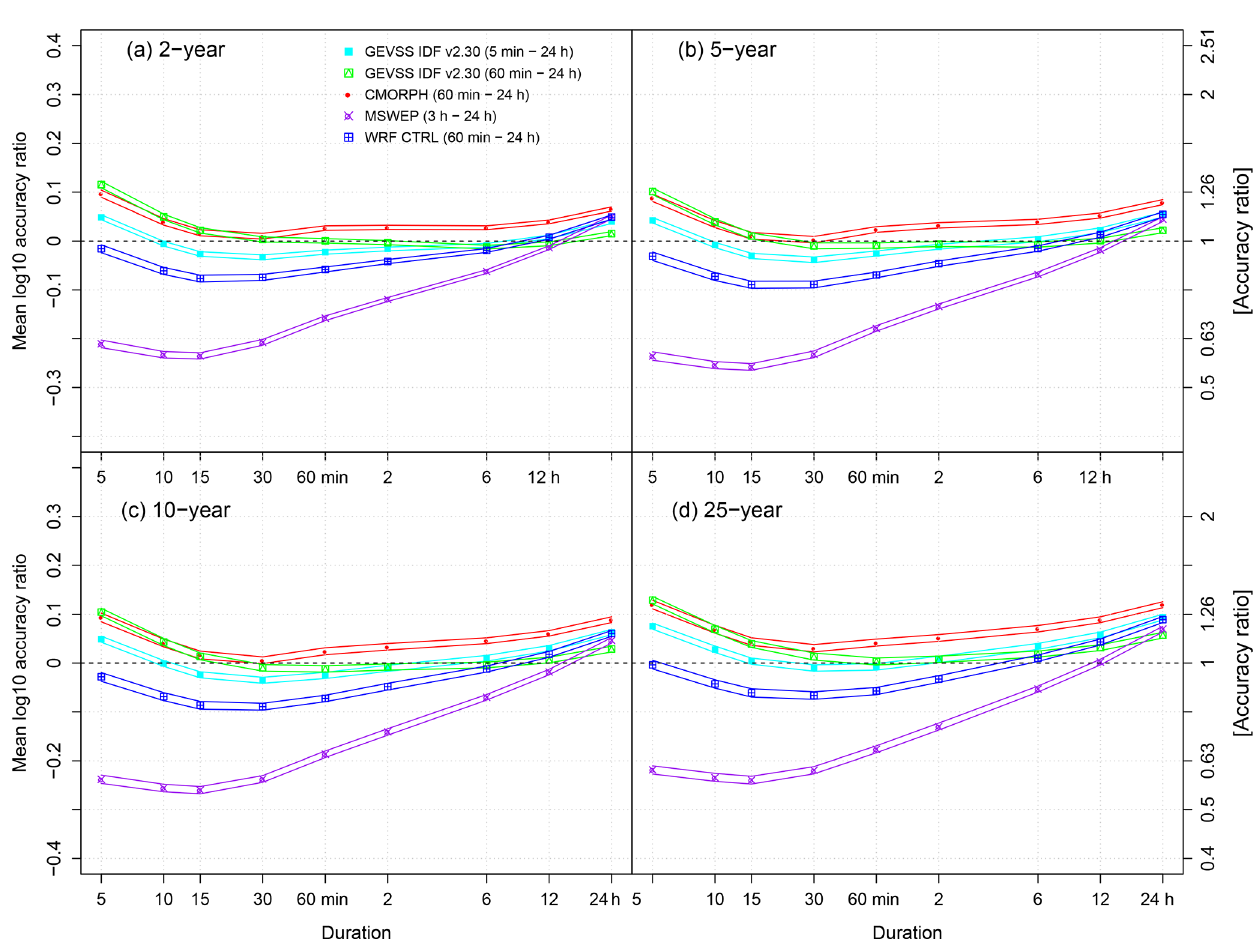
Figure 7. Summaries of MLAR for the GEVSS (a) 50th (2-year return level), (b) 80th (5-year return level), (c) 90th (10-year return level), and 96th (25-year return level) percentile estimates of annual maximum rainfall intensities for each MSWEP, CMORPH, and WRF CTRL gridded dataset. Results are compared with ECCC IDF curve v2.30 estimates for 5min to 24h accumulation durations at 488 TBRG stations. For reference, values are shown for GEVSS IDF curve estimates based on 5min to 24h TBRG data and a restricted set of 60min to 24h durations. Solid lines indicate the 95% credible interval. Perfect performance is indicated by the horizontal dashed